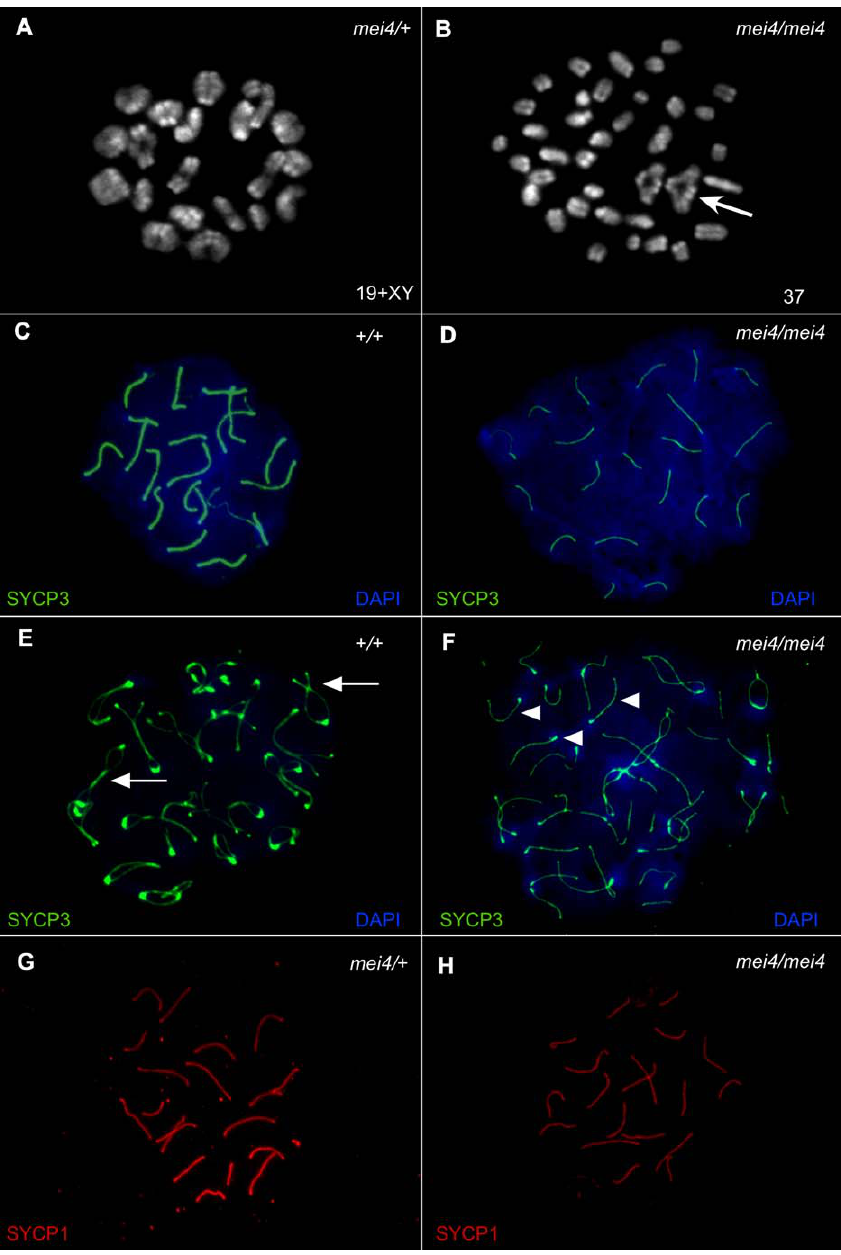
Figure 2. mei4/mei4 Spermatocytes Synapse in Prophase I but Have Few Intact Bivalents at Metaphase